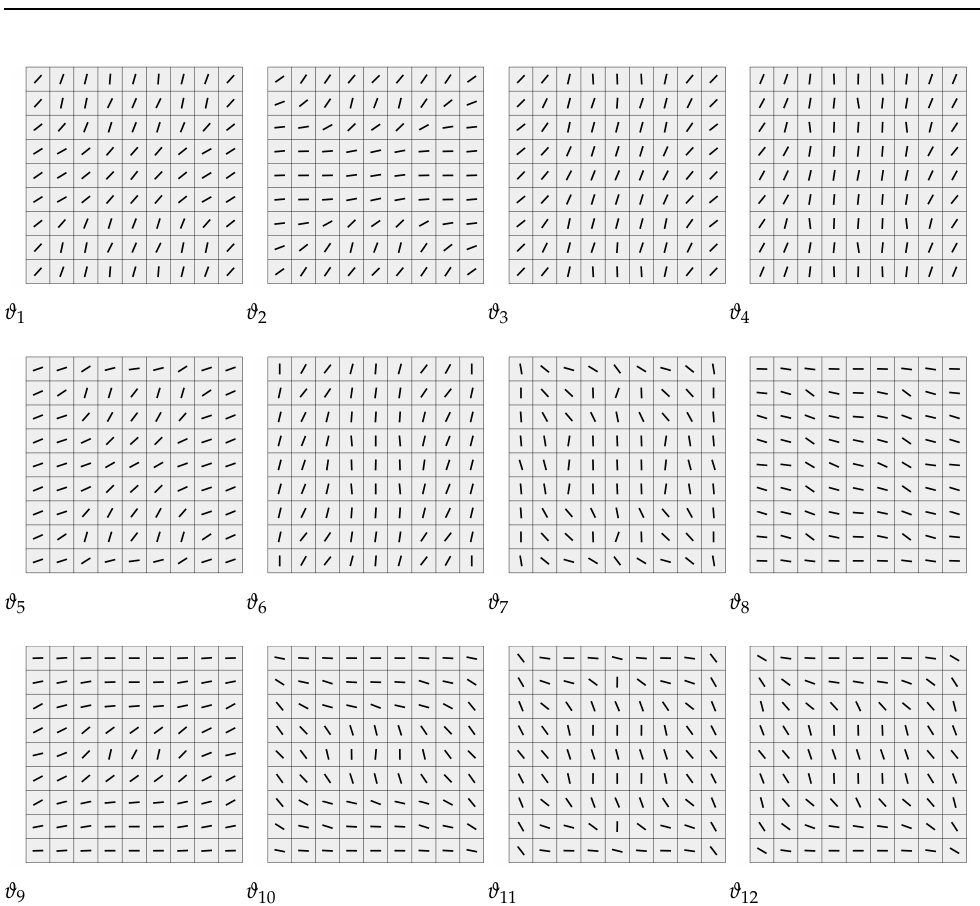
Figure 10. Fibre orientations retrieved by stage 2 for the stacking sequence [